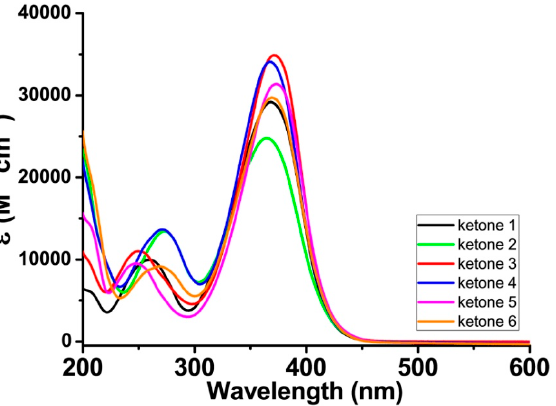
Figure 6. UV-visible absorption spectra of ketones 1–6 in acetonitrile. Reproduced permission from Ref. [234] . Table 1. Optical characteristics of ketones 1–6 in acetonitrile. Data extracted from Ref. [234] .